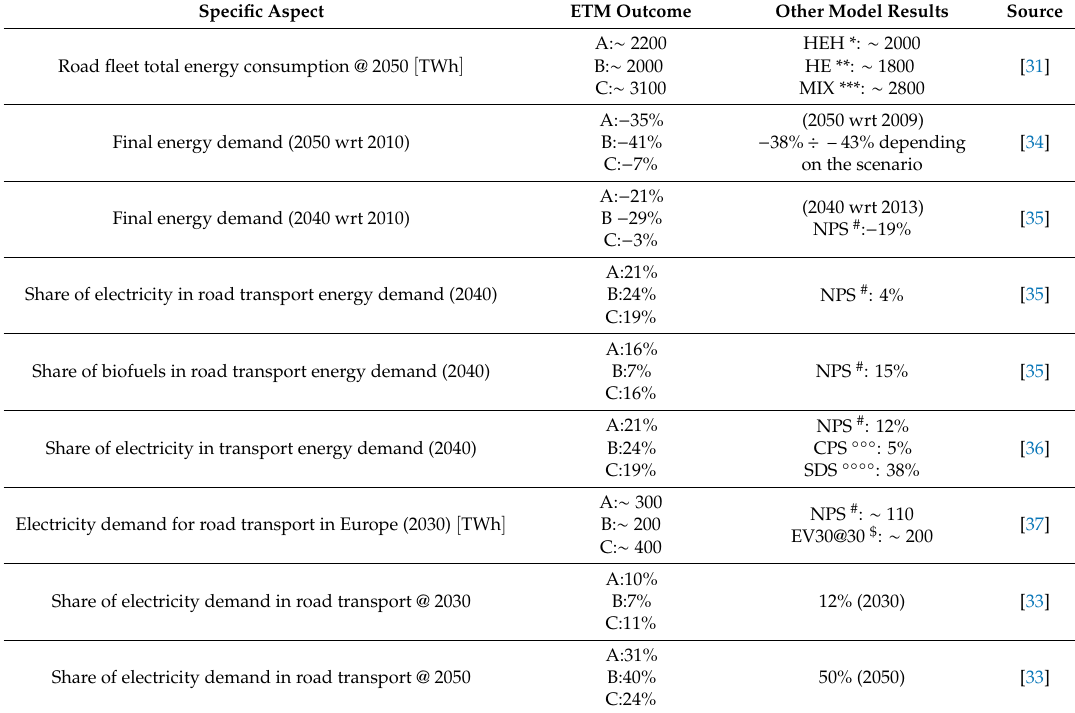
Table 11. Road transport energy consumption: ETM vs. other model